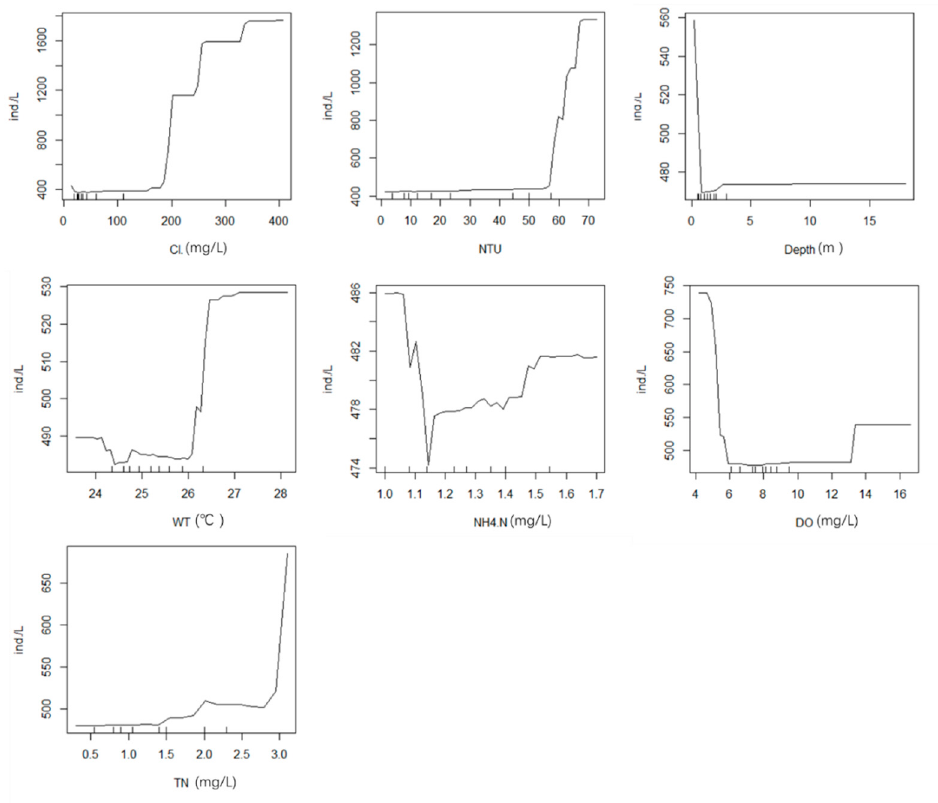
Figure 9. Effects of seven environmental drivers (Cl − , depth, NTU, DO, NH 4+ -N, TN, and WT) on phytoplankton in summer.